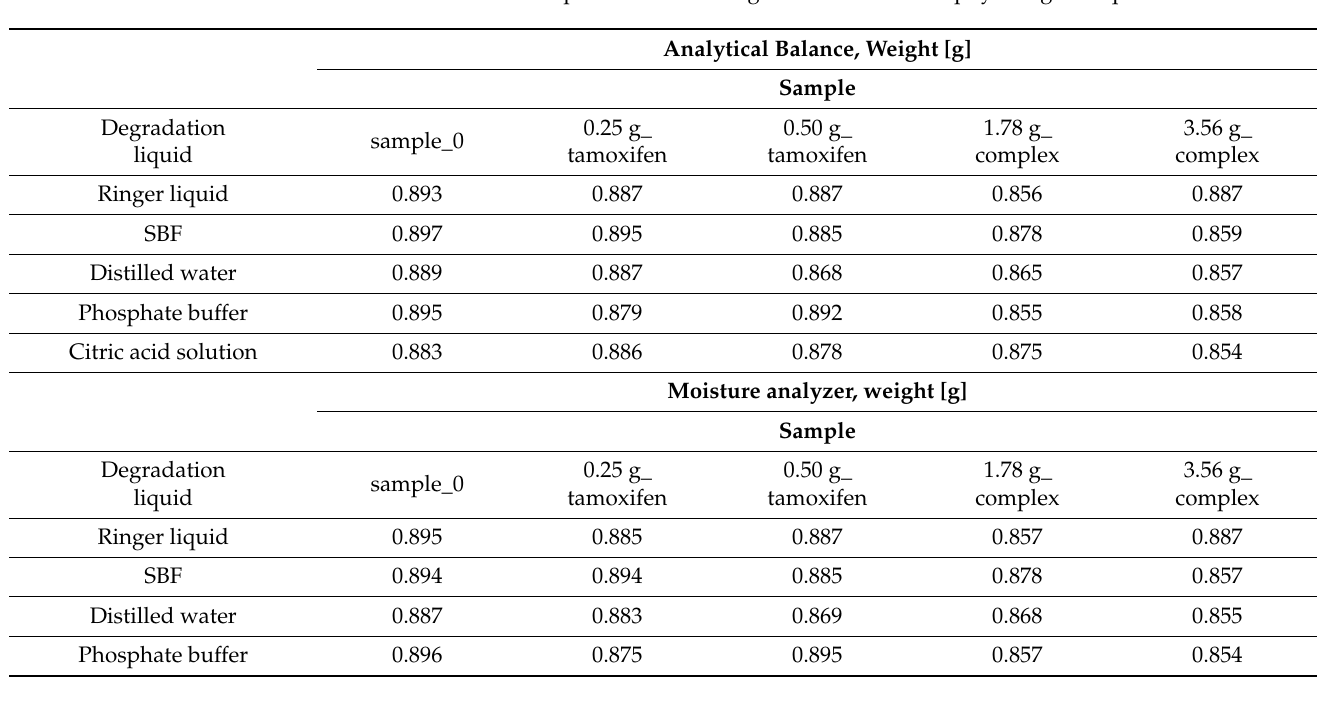
Table 5. Masses of samples verified during their incubation in physiological liquids.